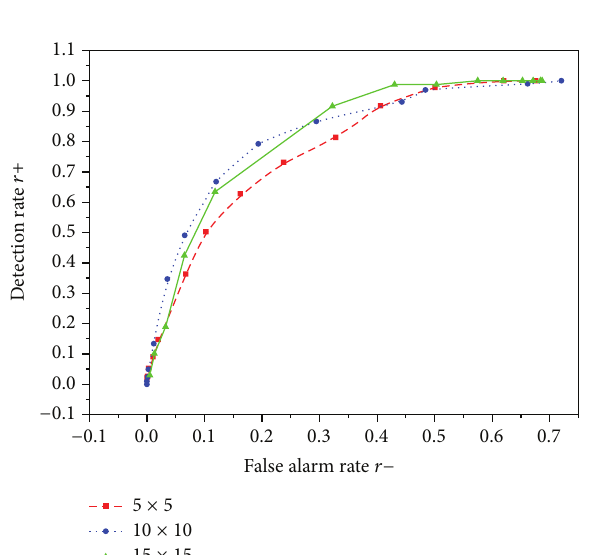
Figure 6: ROC curves of HOG + AdaBoost algorithm under three different HOG CELL sizes.